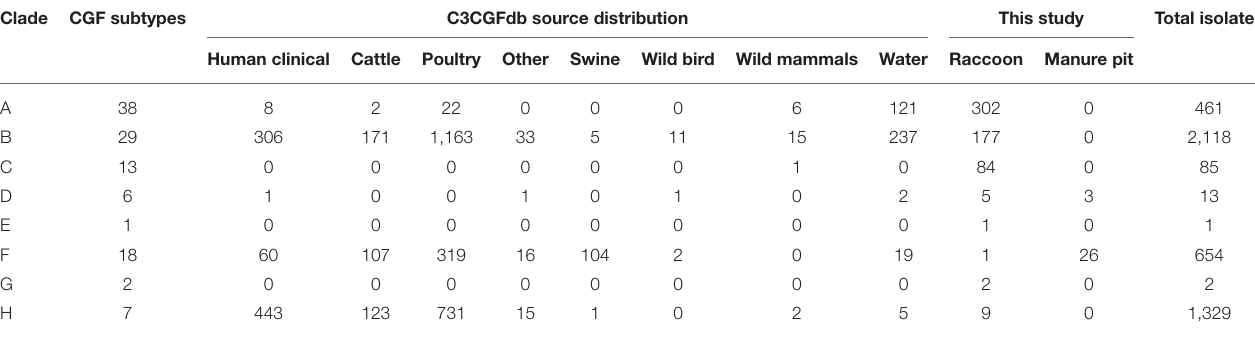
TABLE 2 | Host-source distributions from the C3CGFb for each of the clades observed in raccoon and swine manure pit isolates. Clade CGF